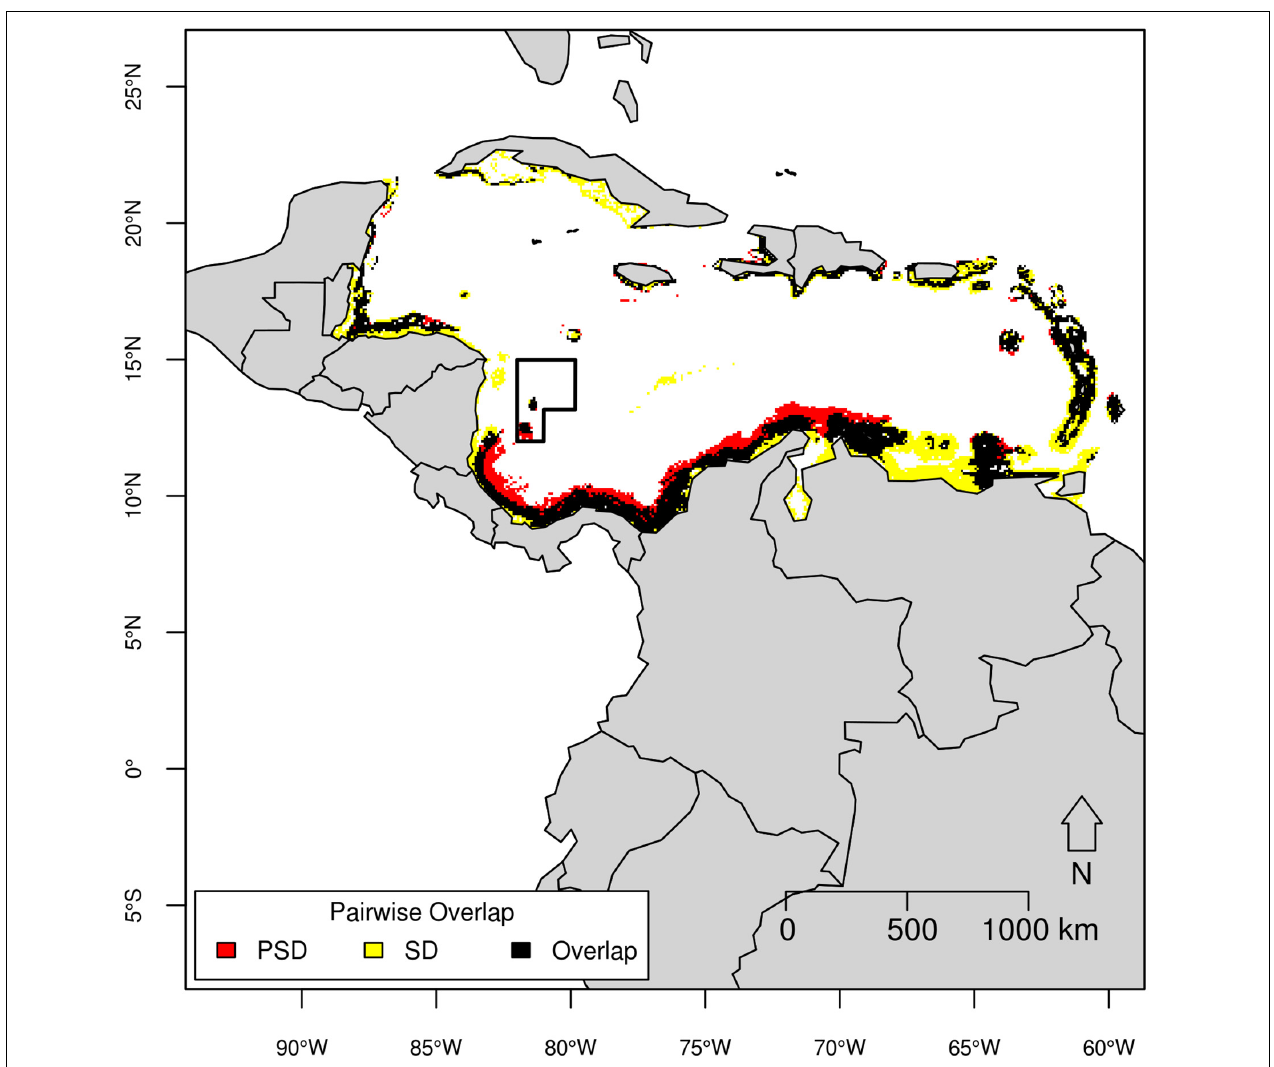
FIGURE 8 | Pairwise overlap map of pantropical spotted dolphin (PSD) and spinner dolphin (SD) based on the threshold of equal test sensitivity and specificity.